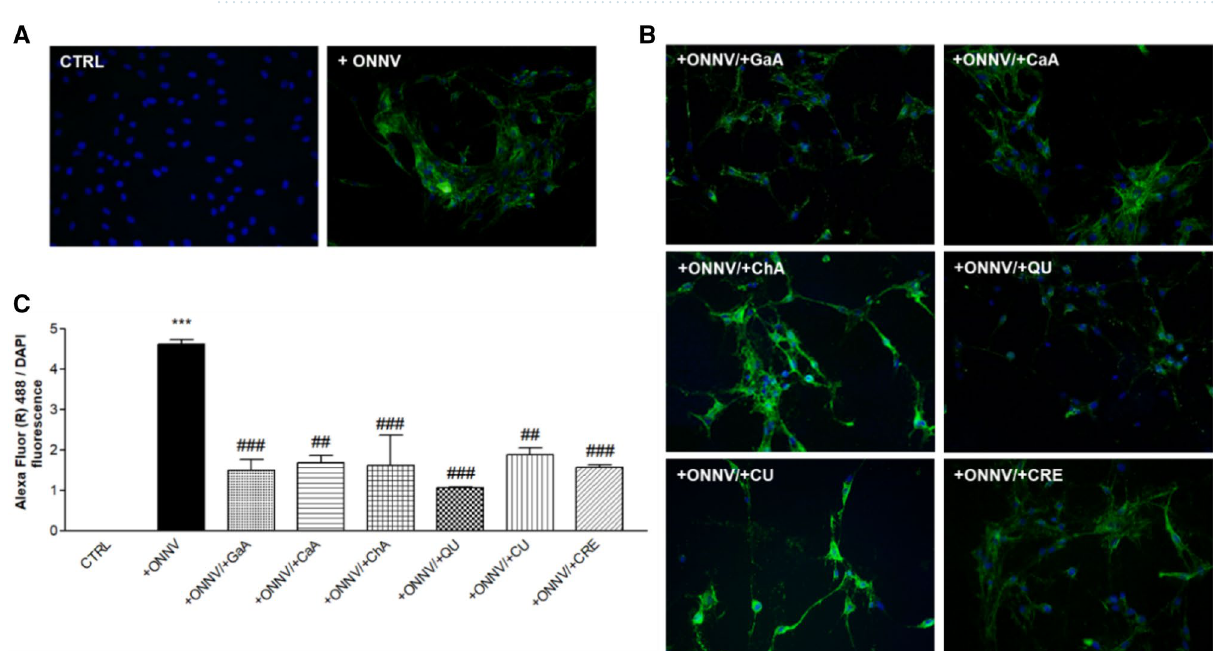
Figure 3. Quercetin impairs HSF cells infection by ONNV. HSF cells were exposed to ONNV (MOI 1) co-treated or not with phenolics (10 µM) for 24 h. Cells were probed with primary antibody Alpha SC 58,088 anti-alphavirus before nuclei staining by DAPI (blue) and antibody binding by Alexa Fluor 488-conjugated donkey anti-mouse IgG antibody (green) ( A ). Untreated cells (CTRL) and infected cells (+ ONNV) ( B ) Alexa Fluor 488/DAPI overlay upon phenolic treatment. ( C ) Ratio Alexa Fluor 488 / DAPI fluorescence intensity with at least 10,000 DAPI stained cells. Reported values are means ± SEM of three independent experiments. p value was calculated using the Bonferroni multiple comparison test (*** p < 0.001) between infected cells (+ ONNV) and untreated cells (CTRL) or ( ## p < 0.01, ### p < 0.001) between infected cells (+ ONNV) and infected cells upon treatment with